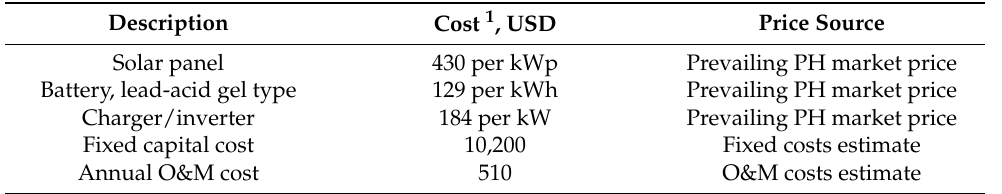
Table 3. Philippine (PH) market price of key microgrid components as used in the HOMER Pro design and the techno-economic analysis.